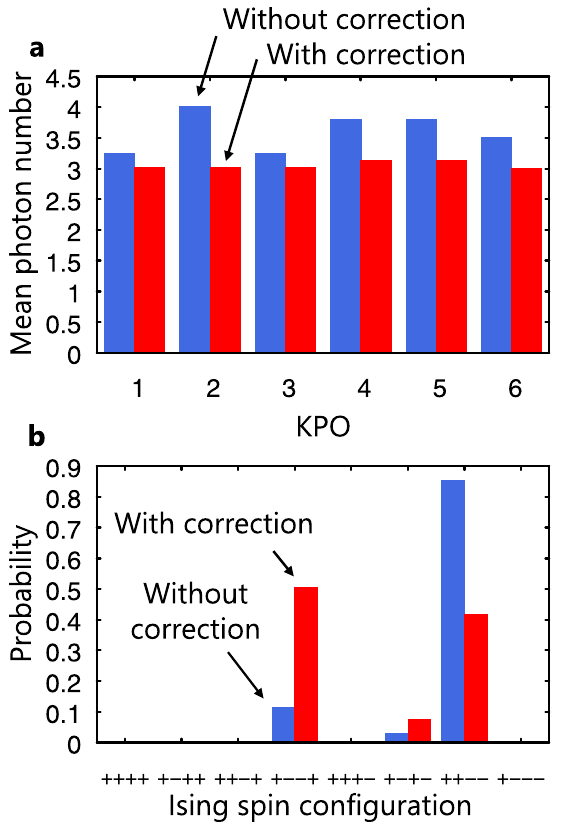
Fig. 2 Results for the four-spin Ising problem with uniform antiferromagnetic interactions. a Mean photon number in each KPO for C = 0.3 and ξ / K = 0.3 (see “ Methods ” for other parameter settings). Here C = 0.3 is chosen because this satis fi es the condition, C > 1/6, for satisfying the four-body constraints (Supplementary Note 1). b Probabilities for the con fi gurations of the Ising spins, s i f g . Only the con fi gurations with s 1 = 1 are shown for the reason mentioned in the main